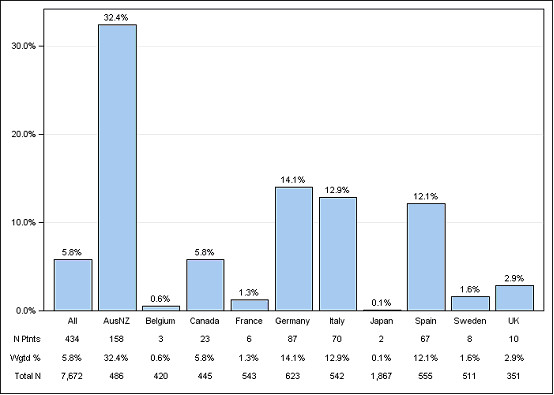
Aluminium binder use by country in DOPPS 3, 2007. (source: http://www.dopps.org/annualreport/html/pb_aub_c_mostrec2009.htm)